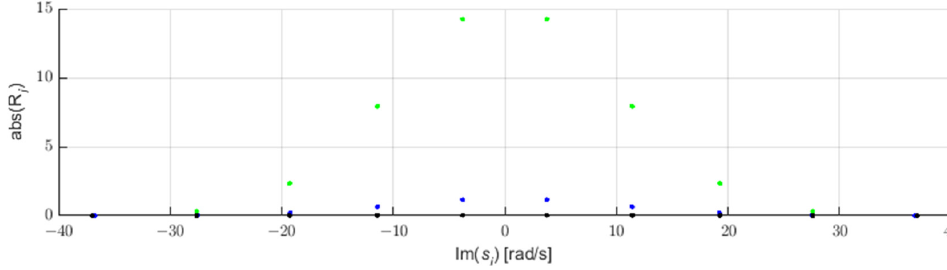
Figure 2. Residues of components of Gaussian approximations.